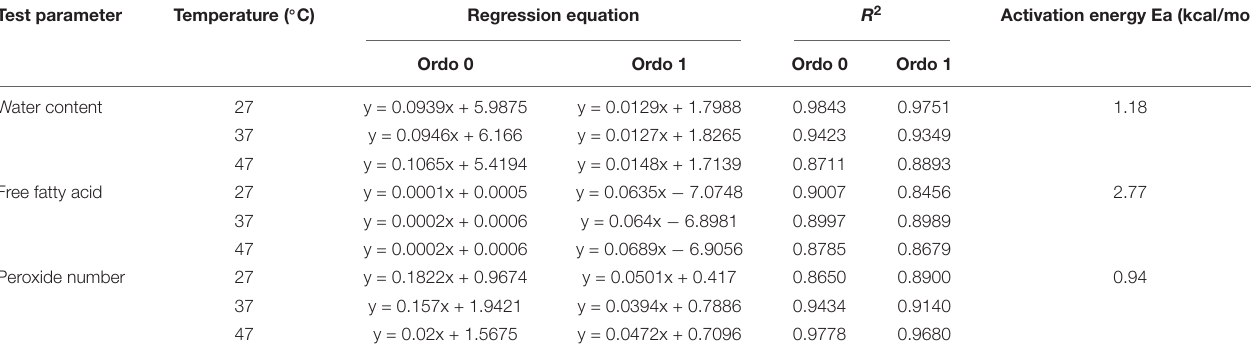
FIGURE 2 | The relationship between water content and free fatty acid (A) , the relationship between water content and peroxide number (B) , during storage at 27, 37, and 47 ◦ C. ( (cid:7) = 27 ◦ C), ( (cid:4) = 37 ◦ C), and ( (cid:78) = 47 ◦ C). Error bar is standard error. n = 4 (2 experiments × 2 replications). TABLE 6 | Comparison of the order of water content parameters, free fatty acid, peroxide number, and activation energy. Test